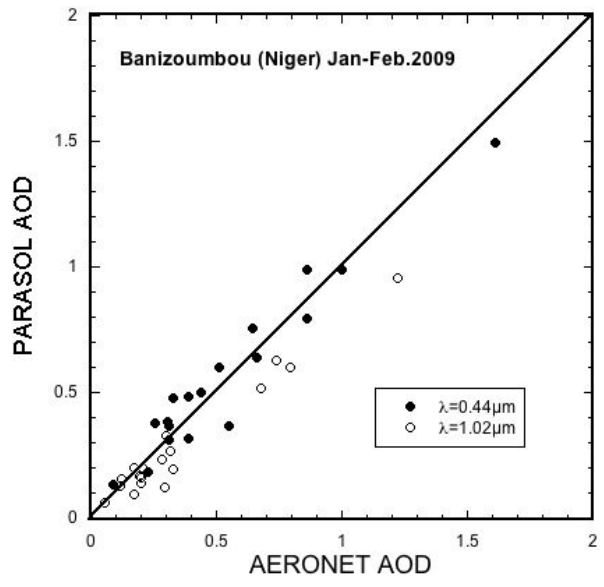
Fig. 4. Scatter plot of the AOD retrieved at 0.440 and 1.020µm from POLDER/PARASOL in January–February 2009 over Banizoum- bou/Niger with the corresponding values provided by